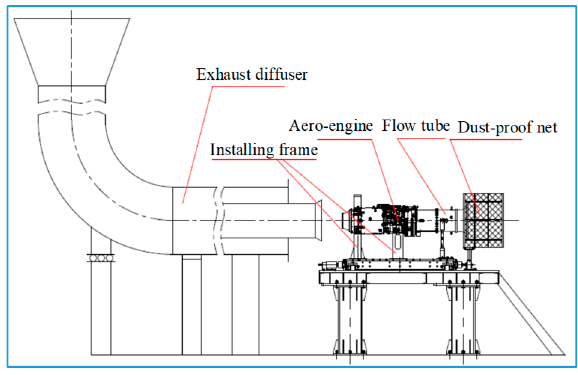
Figure 12. Indoor aeroengine test rig [26].